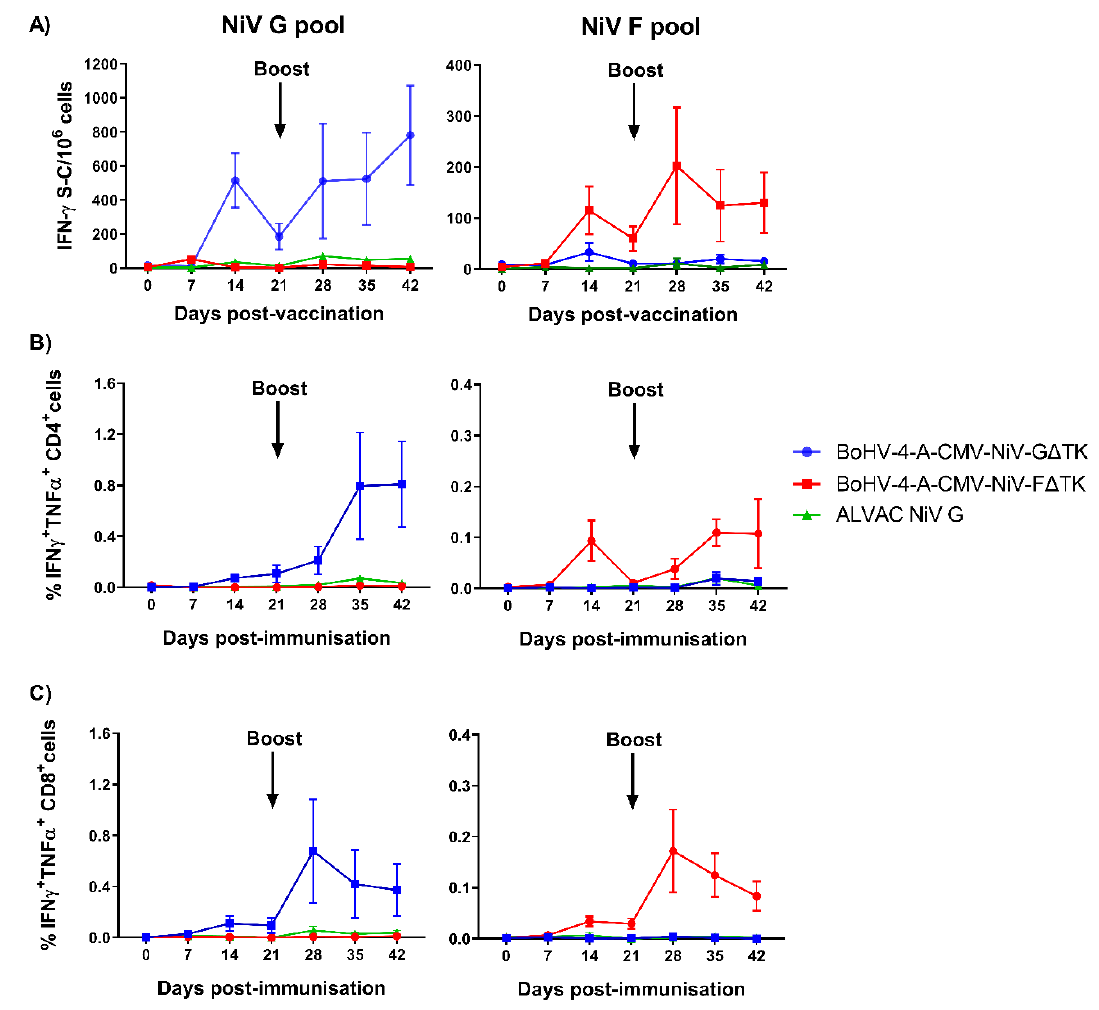
Figure 5. Evaluation of NiV antigen-specific T cell responses following immunization of pigs with BoHV-4 vectors. Pigs were immunized with BoHV-4-A-CMV-NiV-F ∆ TK, BoHV-4-A-CMV-NiV-G ∆ TK or ALVAC NiV G on 0 (prime) and 21 (boost) dpv. Responses of PBMC to stimulation with NiV G and F peptide pools was monitored weekly by IFN- γ ELISpot and responding cells phenotyped by intracellular cytokine staining (ICS) assays. ELISpot data are presented as the mock-corrected number of IFN- γ spot forming cells (S-C) per million peripheral blood mononuclear cells (PBMCs) ( A ) and ICS data shown as the medium-corrected % TNF- α + IFN- γ + CD4 + ( B ) and CD8 α + cells ( C ). Mean data ± SEM are shown for each vaccine